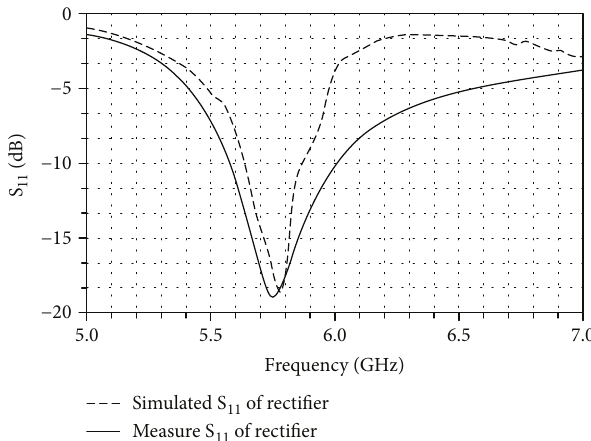
Figure 11: The simulated and measured S